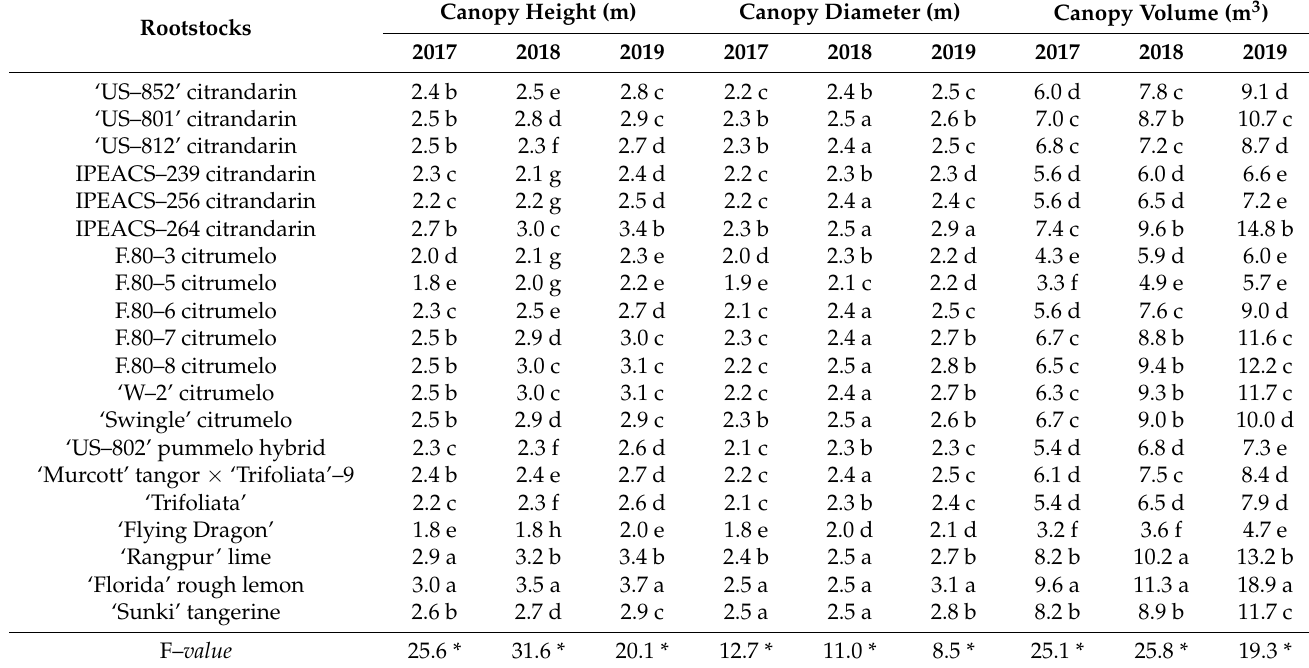
Table 2. Tree growth development of ‘Valencia’ sweet orange trees grafted on 20 rootstocks.